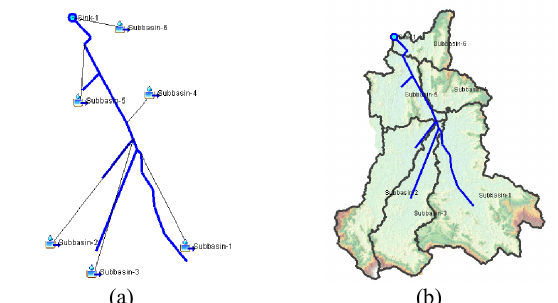
Figure 4. (a) Schematic diagram and (b) delineated watershed polygon of Sungai Lebir basin